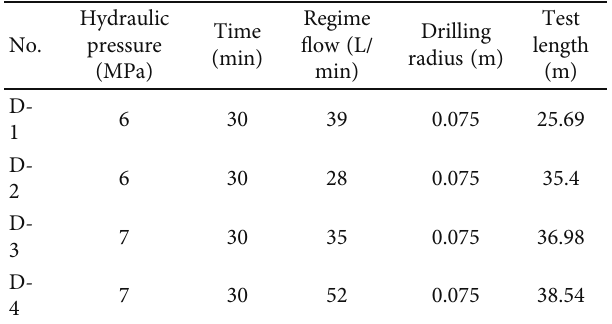
Table 4: Calculation table of speci fi c water absorption, permeable rate, and hydraulic conductivity of Xujiazhuang limestone aquifer after grouting